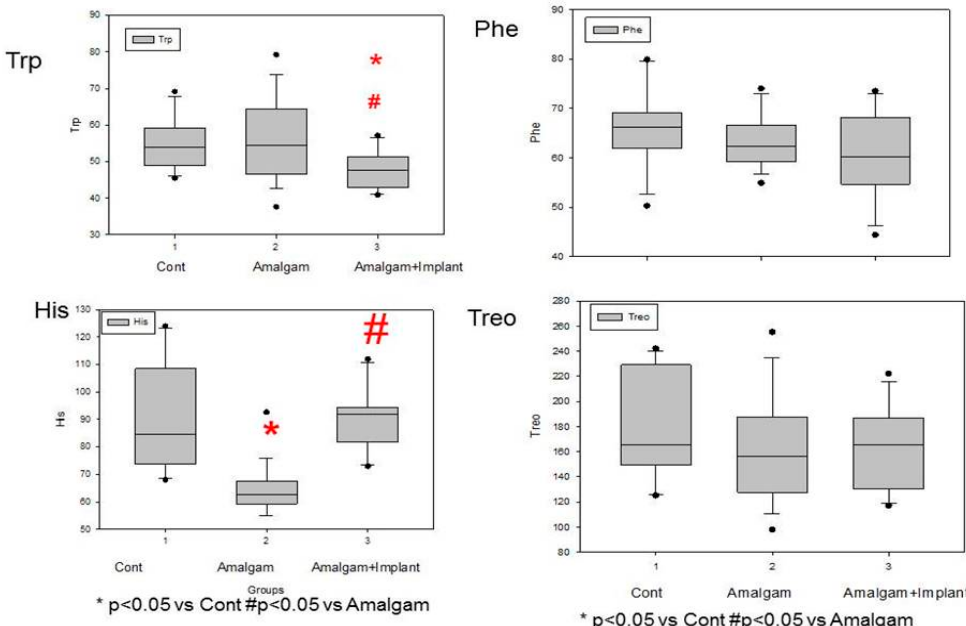
Figure 2. Lower systemic Trp or His levels in patients who have long-term titanium dental implants and amalgams (for at least 10 years: average: 15, A + I) than in participants with long-term dental amalgams alone (A). Cont: control ( n = 30). Amalgam (A, n = 55). Dental titanium implants + Amalgam (A + I, n = 57). * p < 0.05 vs. Control group (Cont), # p < 0.05 vs. Amalgam group (A).